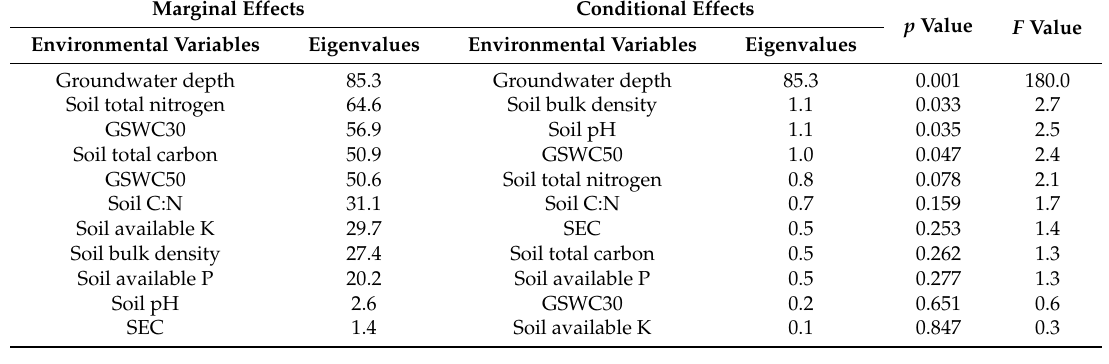
Table 3. Marginal and conditional effects obtained from the forward selection of the Monte Carlo test.